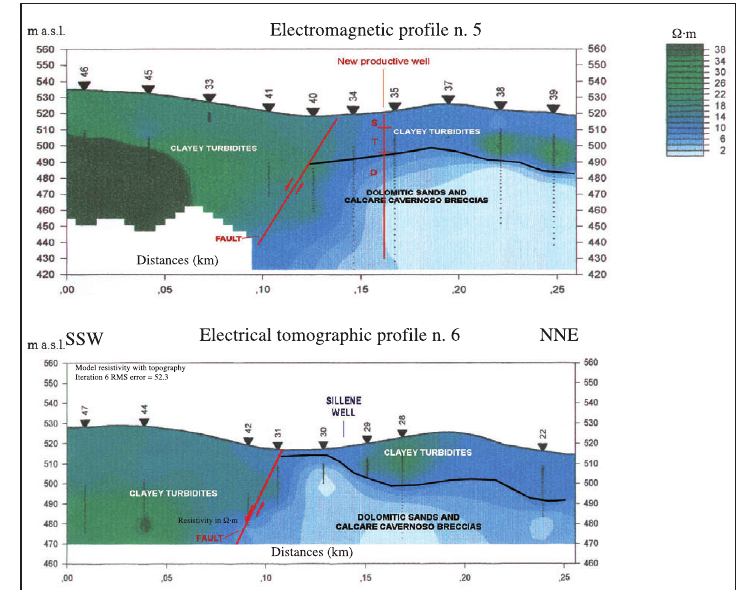
Fig. 8. Profile n. 4.